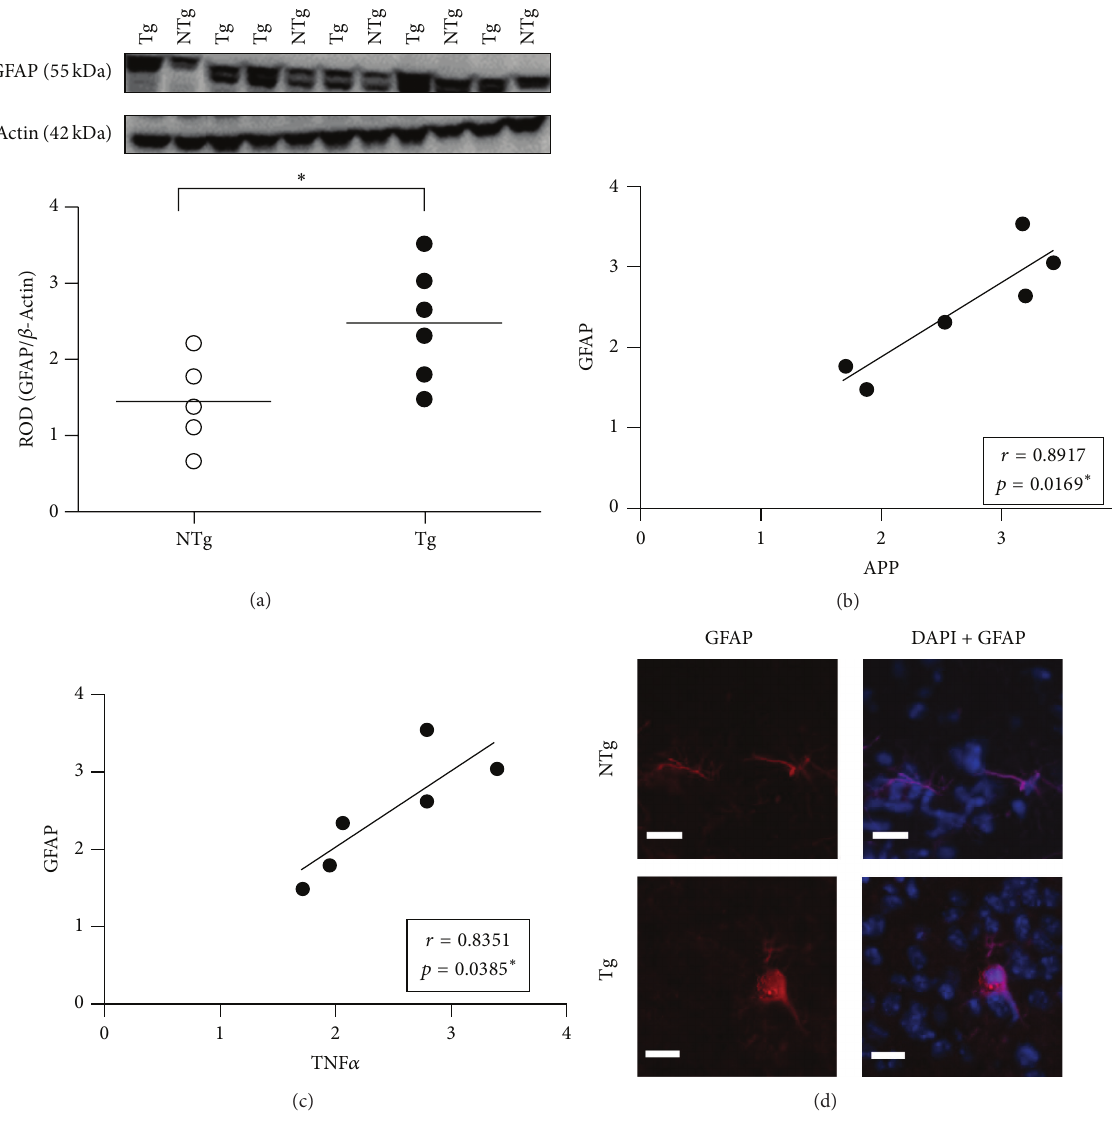
Figure 2: Quantification of GFAP expression in the hippocampus of 3-month-old WT and APPswe/PS1dE9 mice. (a) Representative immunoblot of GFAP (55 kDa) expression in hippocampal protein extracts coming from WT ( 𝑛 = 5 ) and APPswe/PS1dE9 ( 𝑛 = 6 ). Semiquantitative analysis of immunoblot was performed using ImageJ software. The immunoreactivity of each protein band was normalized to 𝛽 -actin (42 kDa) immunoreactivity. The results were expressed as relative optical density (ROD); ∗ indicates 𝑝 < 0.05 . (b) The increase in GFAP correlates positively with APP ( 𝑟 = 0.8917; 𝑝 = 0.0169 ) and (c) TNF 𝛼 ( 𝑟 = 0.8351; 𝑝 = 0.0385 ) among the APPswe/PS1dE9 mice analyzed according to the animal-by-animal basis. Linear regression analysis (b and c) was performed using the ROD values shown in Figures 2(a), 1(a), and 1(b) for GFAP, APP, and TNF 𝛼 , respectively. ∗ indicates 𝑝 < 0.05 . (d) Confocal microscopy of the morphology of GFAP-IR cells (red) and DAPI for nuclei (blue) in the CA1-2 hippocampal subregion of WT (upper) and APPswe/PS1dE9 (lower) mice. Scale bar: 50 𝜇 m. NTg: wild type; Tg: